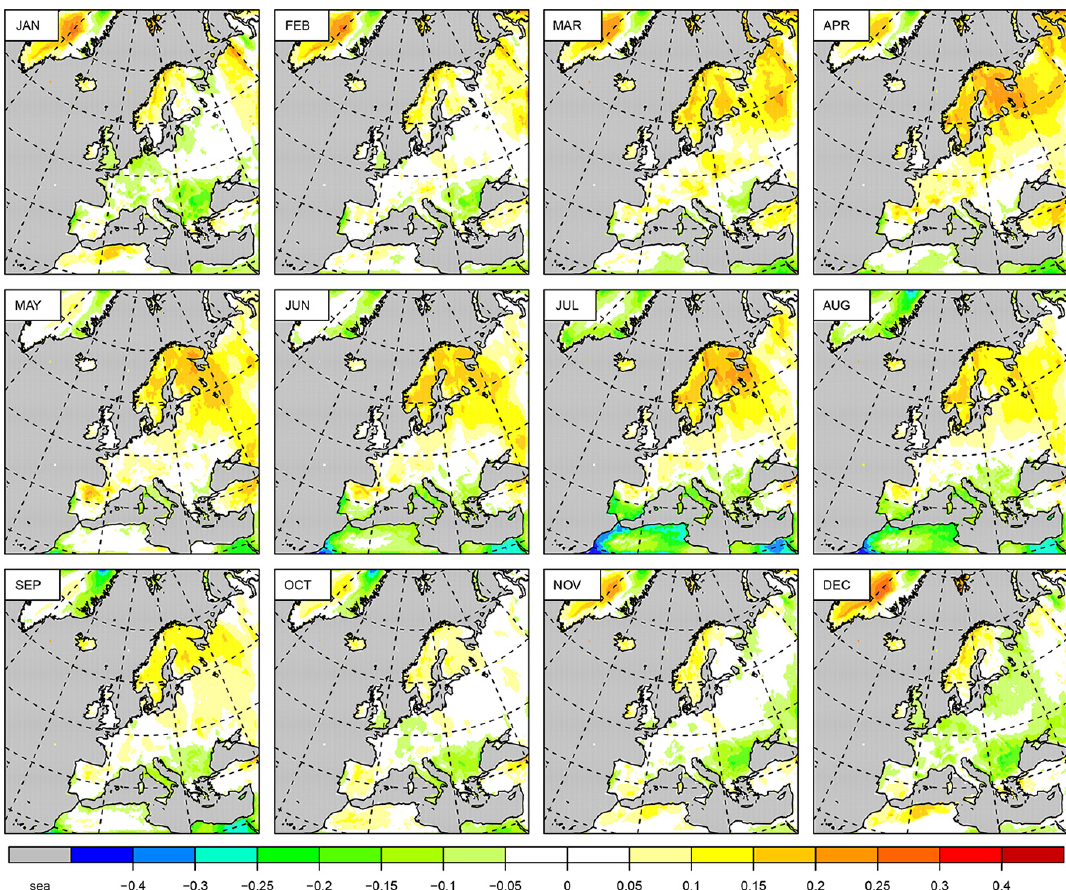
Figure 11. Di ff erences of mean monthly means of total cloud cover [1] from 1950 to 2010: coastDat2-CCLM minus